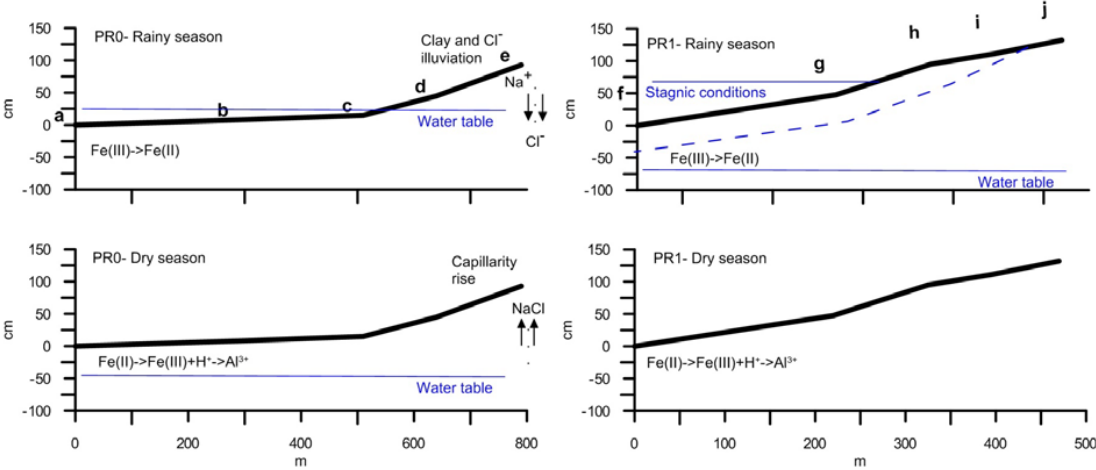
Figure 9. Processes of soil formation in PR0 and PR1. Savannahs in both PR0 and PR1 are seasonally wet and dry, with Fe reduction during the rainy season and Fe oxidation during the dry season. Levees in PR0 are affected by mobility of Cl − and clay which are transported to the B horizon (clay) or deeper (Cl − ) during the rainy season. In PR1 waterlogging is due to local rain, without the contribution of groundwater table rise, causing weak stagnic conditions. During the dry season, the presence of salt-rich groundwater in PR0 causes the capillarity rise of NaCl. The seasonal alternation of capillarity rise of NaCl and eluviation of Cl − leads to an enrichment of Na + and the formation of NaOH with a consequent increase in pH. In PR1 the disappearance of the stagnic conditions during the dry season is followed by Fe oxidation along root